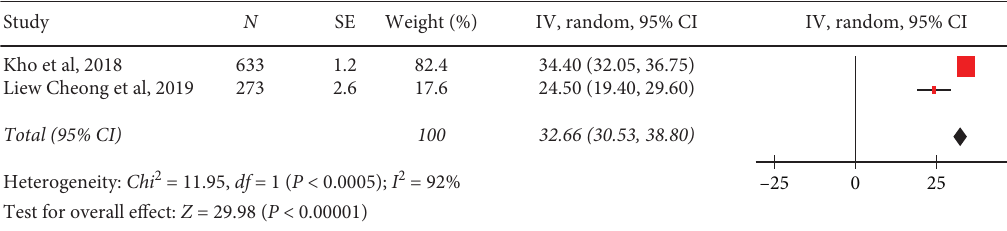
Figure 4: Forest plot of the studies among a school